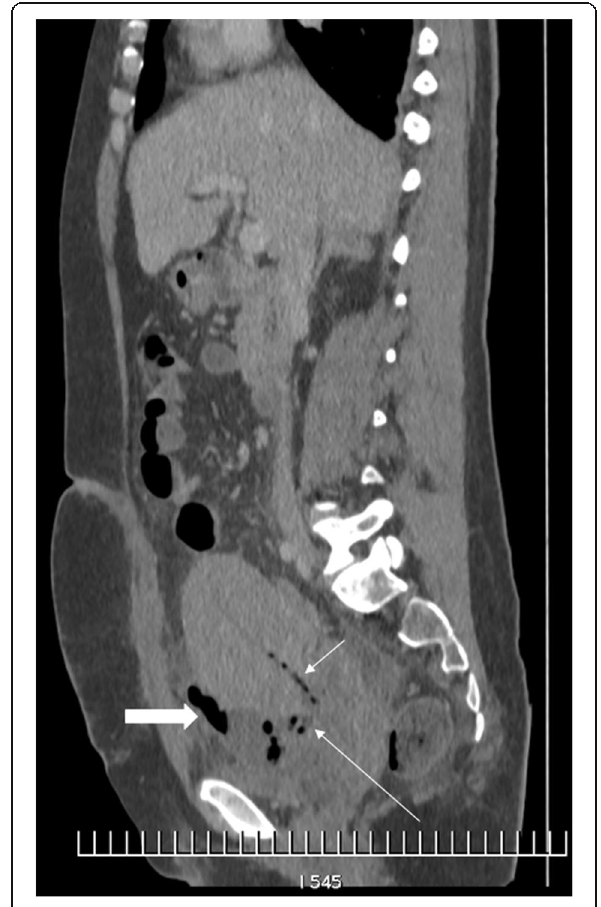
Fig. 1 A 33-year-old woman 6 days after repeat C-section in 2nd pregnancy. CT is performed due to fever, pain, left costovertebral angle tenderness, and increasing serum level of C-reactive protein (485 mg/l) and procalcitonin (6.7 ng/ml), with a suspicion of renal colic or endometritis. CT revealed gas within the C-section incision in the uterine wall (long arrow) and in the uterine cavity (short arrow), as well as an abscess in front of/under the uterus (thick arrow), shifting the bladder to the left. Two hours later, the patient was operated on, and the abscess was evacuated Table 1 The proposed scanning protocol of pelvic MRI Sequence